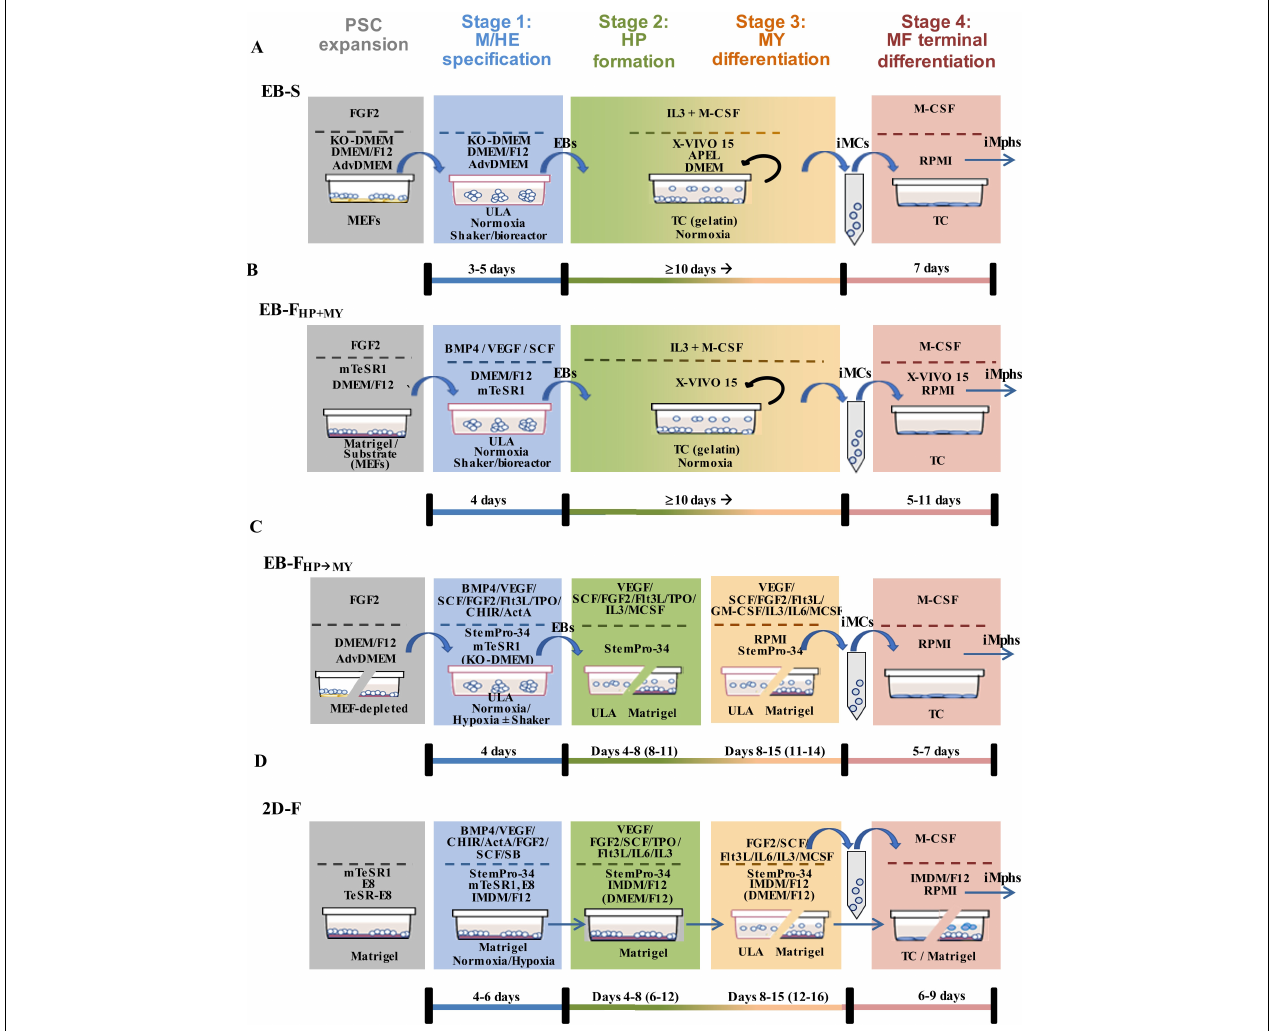
FIGURE 3 | Schematic representation of different types of protocols used to generate iMphs from pluripotent stem cells. Different types of protocols are currently employed to generate iMphs from PSCs (A) EB-S protocols. PSCs are expanded on MEFs. At the M/HE stage, mesoderm/HE are induced through the formation of EBs in ULA plastic. For HP and MY stages, EBs are transferred to TC plates and cultured in the presence of IL-3 and M-CSF. Floating cells that appear in the cultures are collected, centrifuged, filtered, and transferred to new TC plates for terminal differentiation (MF stage) in the presence of M-CSF. Remaining cells are restimulated with IL-3 and M-CSF for continuous generation of iMCs. (B) EB-F HP + MY protocols. In most protocols, PSCs are expanded on matrix-coated plates. At the M/HE stage, EBs are formed in ULA plastic, where the formation of mesoderm/HE is directed by exogenous factors. For HP and MY stages, EBs are transferred to new TC plates and cultured in the presence of IL-3 and M-CSF. This and further stages are performed exactly as in EB-S protocols. Remaining cells are restimulated with IL-3 and M-CSF for continuous generation of iMCs. (C) EB-F HP → MY protocols. PSCs are depleted from MEFs prior to differentiation. EBs are formed in ULA plastic, where M/HE stage is directed by exogenous factors in normoxia or hypoxia conditions. After that, EBs are transferred to ULA or Matrigel-coated TC plates, where HP stage is induced by exogenous factors. MY differentiation is directed in the same plates by changing the composition of exogenous factors. Floating cells that appear in the cultures are collected, transferred to TC plates, and terminally differentiated. (D) 2D-F protocols. PSCs are always prepared in Matrigel-coated plates in defined media. For M/HE induction, the cells are plated to matrix-coated plates and cultured in the presence of M/HE-inducing exogenous factors in normoxia or hypoxia conditions. HP differentiation is usually induced in the same wells by adding HP-inducing exogenous factors. For MY differentiation, the cells are either transferred to ULA plastic or left in the same Matrigel-coated wells and are stimulated with a new mixture of factors. At the MF stage, floating cells that are formed in ULA conditions are transferred to TC plates and cultured in the presence of M-CSF. If at the MY stage the cells were cultured in Matrigel-coated wells, they continue to be cultured in the same wells; the MF stage is induced by adding M-CSF. In the figure, the lists of factors